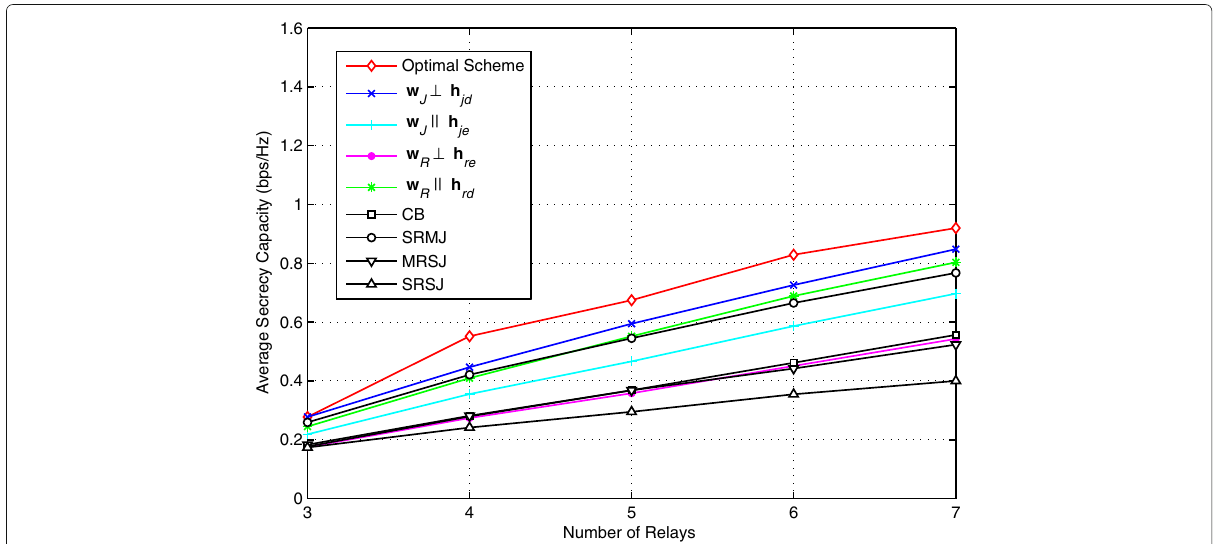
Fig. 4 The average secrecy capacity as a function of the number of relays N for DF relay network, P t = 10 dB, P s = 0 dB